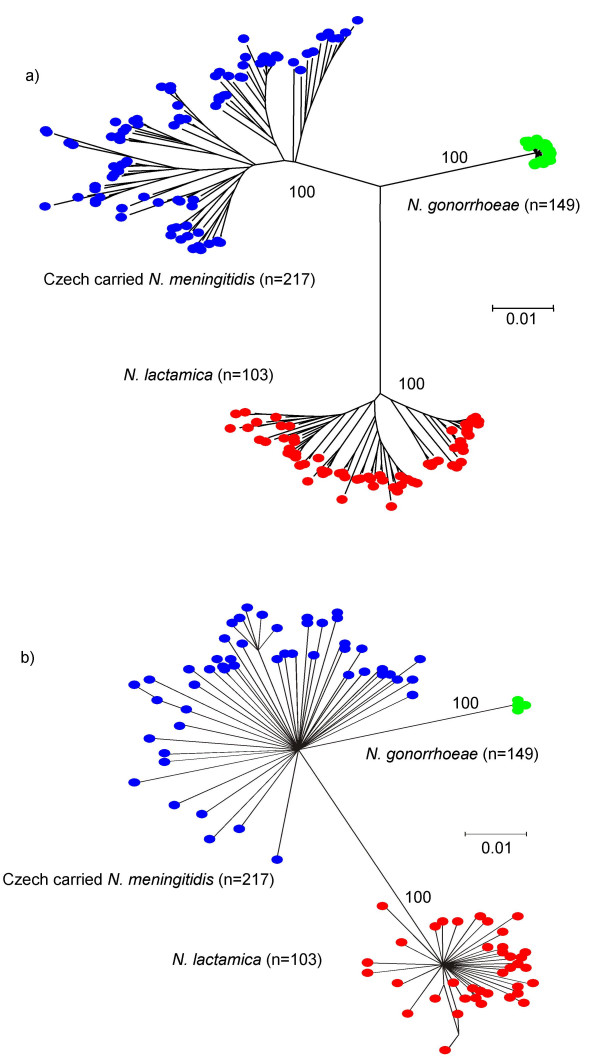
MLST data resolves N. gonorrhoeae, N. meningitidis and N. lactamica into three clusters. (a) A neighbour-joining tree was constructed from the concatenated MLST sequences for each species. (b) A splits graph was constructed from the concatenated MLST sequences for each species. Bootstrap values are indicated for the main branches (2000 replications).